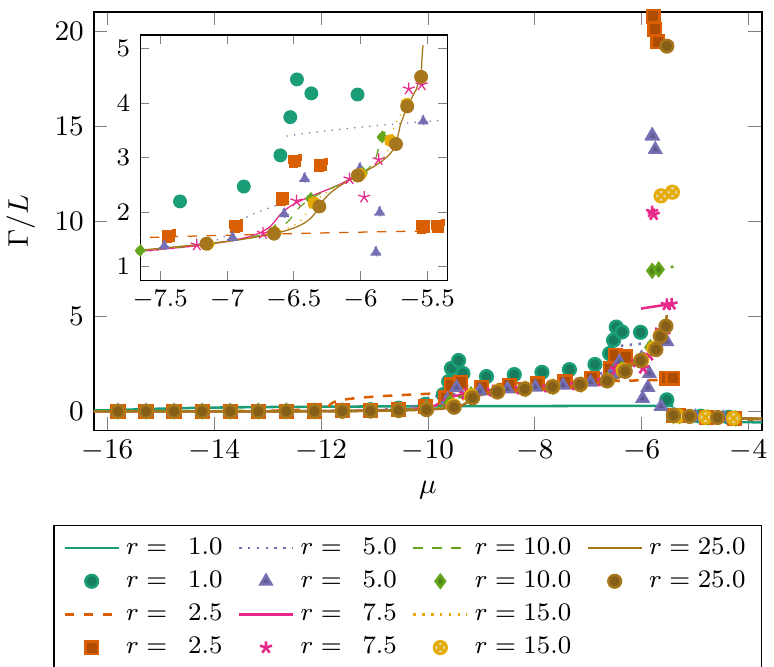
Figure 11. Dimensionless 2D excess adsorption, Γ / L , as a function of the dimensionless chemical potential, µ , for a Lennard-Jones fluid. Only the simulation results from Figure 1 when χ = 1 are shown. The different lines show the results of the cDFT simulations while the symbols show the grand potential as reconstructed from the Minkowski functionals and one set of Minkowski functional coefficients: the derivatives of pressure, ∂ ( p − p b ) / ∂µ , pressure per surface area, p (cid:48) ( µ , T ) , surface tension, ∂σ / ∂µ , bending rigidity, ∂κ / ∂µ , and the pseudo pressure and surface tension terms ∂ p (cid:48) / ∂µ and ∂σ (cid:48) / ∂µ with respect to the chemical